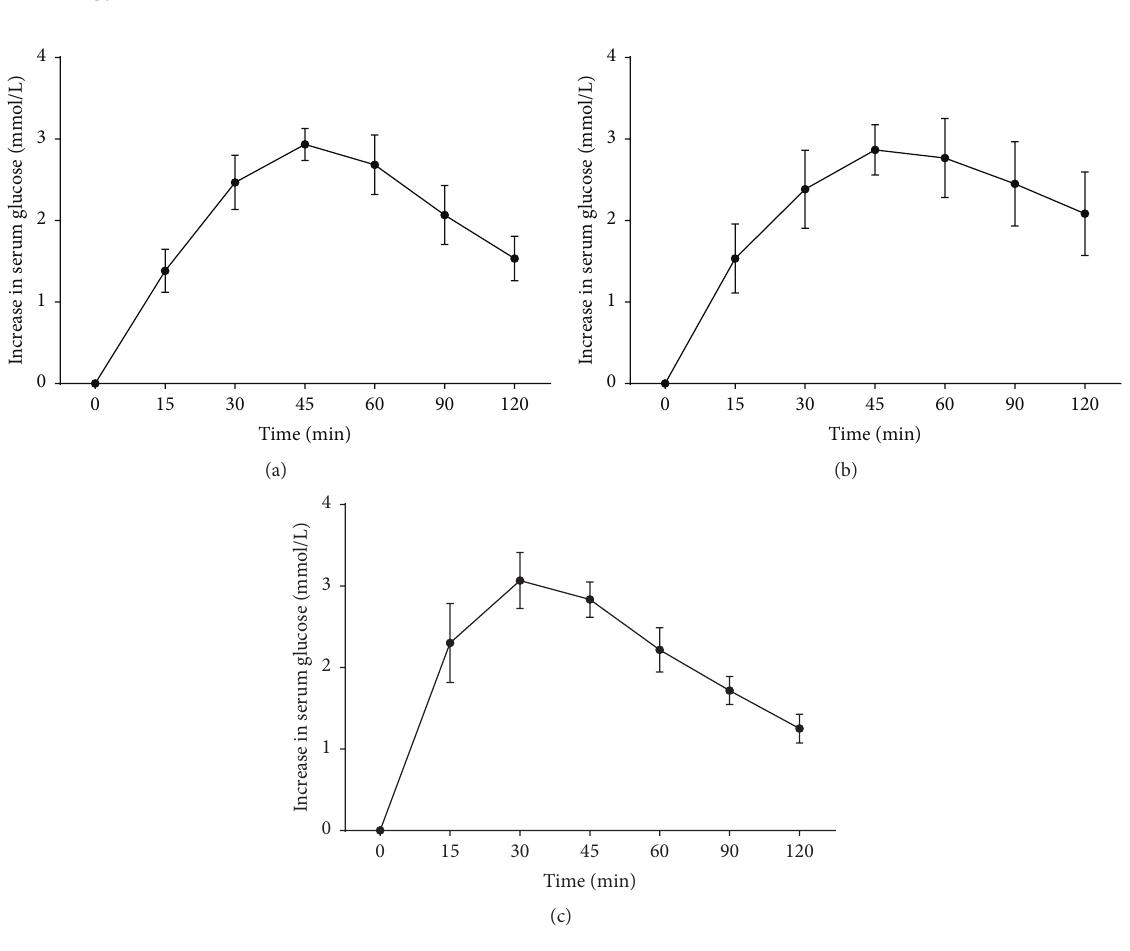
Figure 4: Maltose absorption test at day 7 after